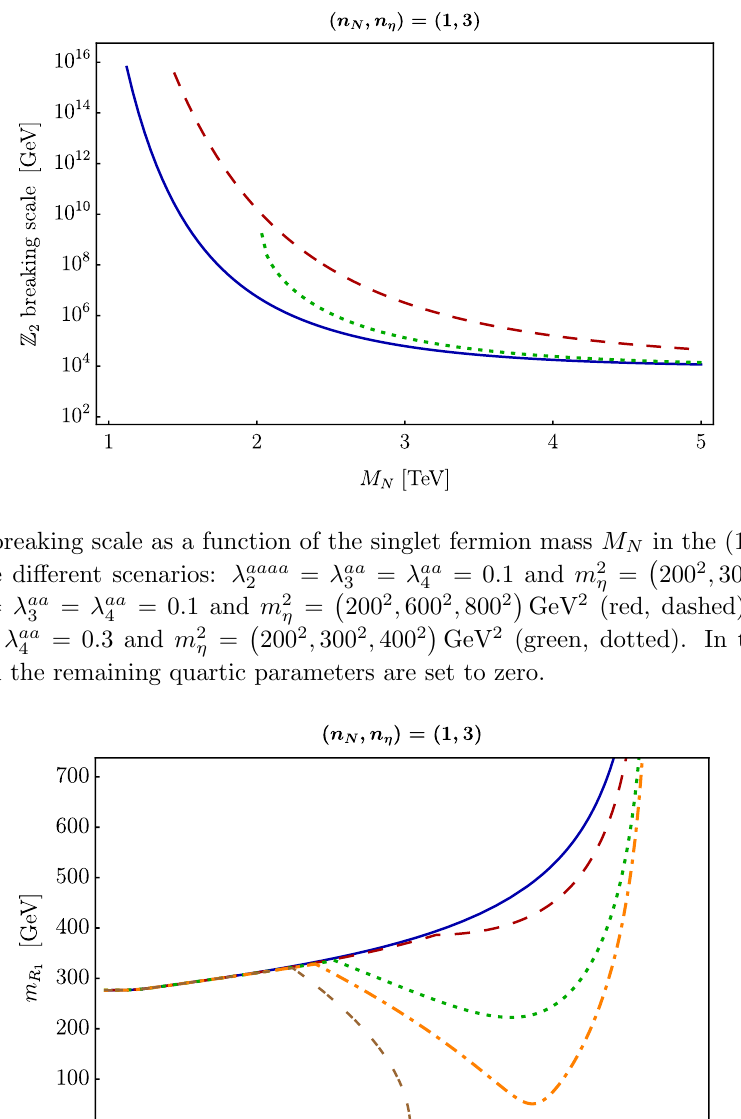
as a function of the energy scale (cid:22) in the (1 ; 3) 1 = (cid:21) aabb = (cid:21) aa = (cid:21) aa = 0 : 3, (cid:21) aa = 10 (cid:0) 9 2 2 3 4 5